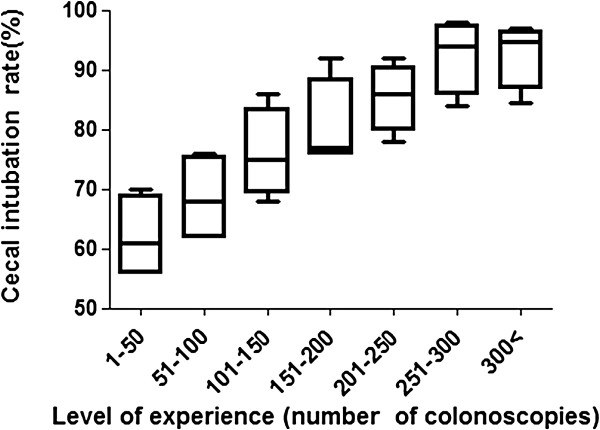
Cecal intubation rate learning curves. The learning curve for average successful cecal intubation rates within 15 minutes based on the number of colonoscopies is shown. (P < 0.05 with the Turkey test, error bars represent the 95% confidence interval). Cecal intubation rates reach the 92.5% at 250-300th procedures.